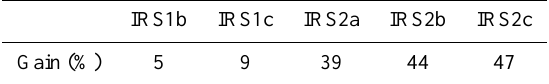
Table 5. Impact of spectral resolution and radiometric noise on the accuracy of the retrieval of CH 4 tropospheric columns, expressed relative to the IRS1a-IASI accuracy